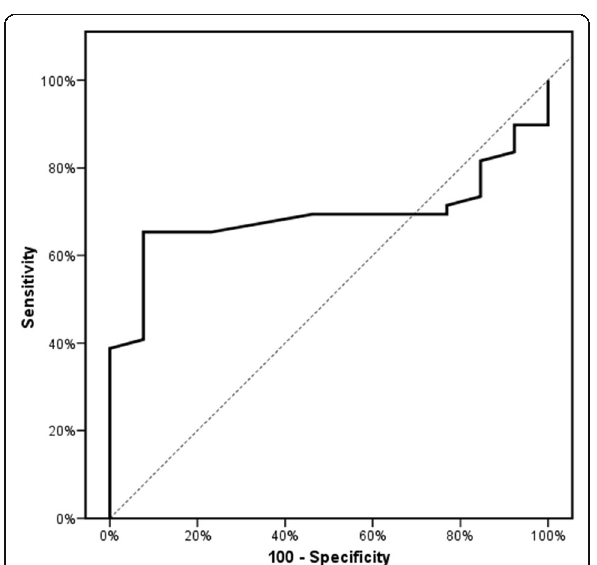
Fig. 5 ROC curve to assess agreement (sensitivity, specificity) of the ADC ratio to diagnose cases with clear cell RCC from other masses. A cutoff ADC ratio of > 0.56 × 10 − 3 mm 2 /s to diagnose cases with clear cell RCC from other masses can be used with a sensitivity of 88.89% and specificity of